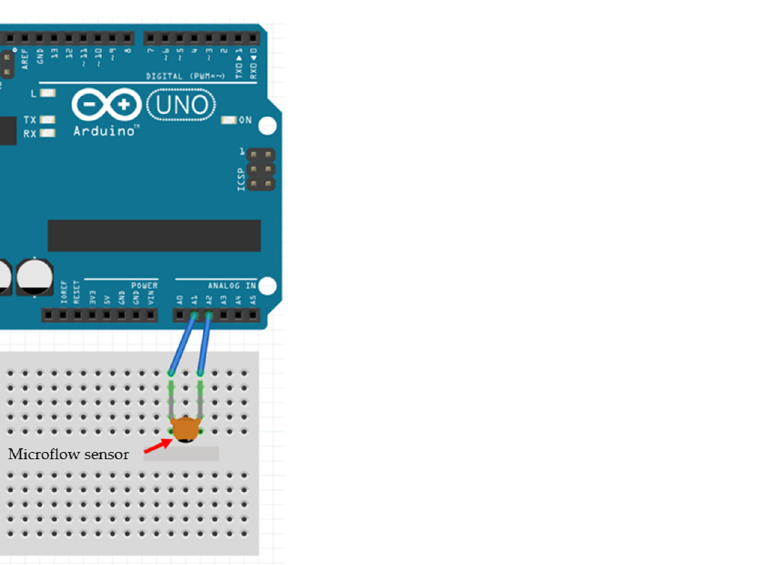
Figure 7. The Arduino Uno Rev 3 development board was connected to the microflow sensor.